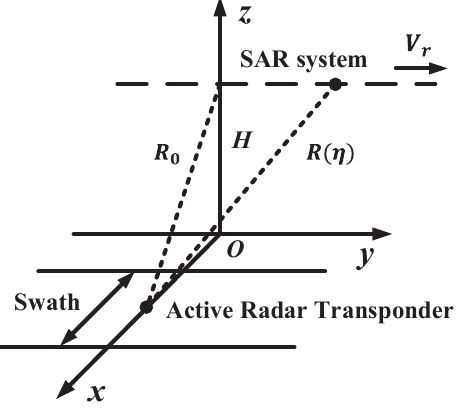
Figure 1. Geometric model of jamming scenario based on active radar transponder.